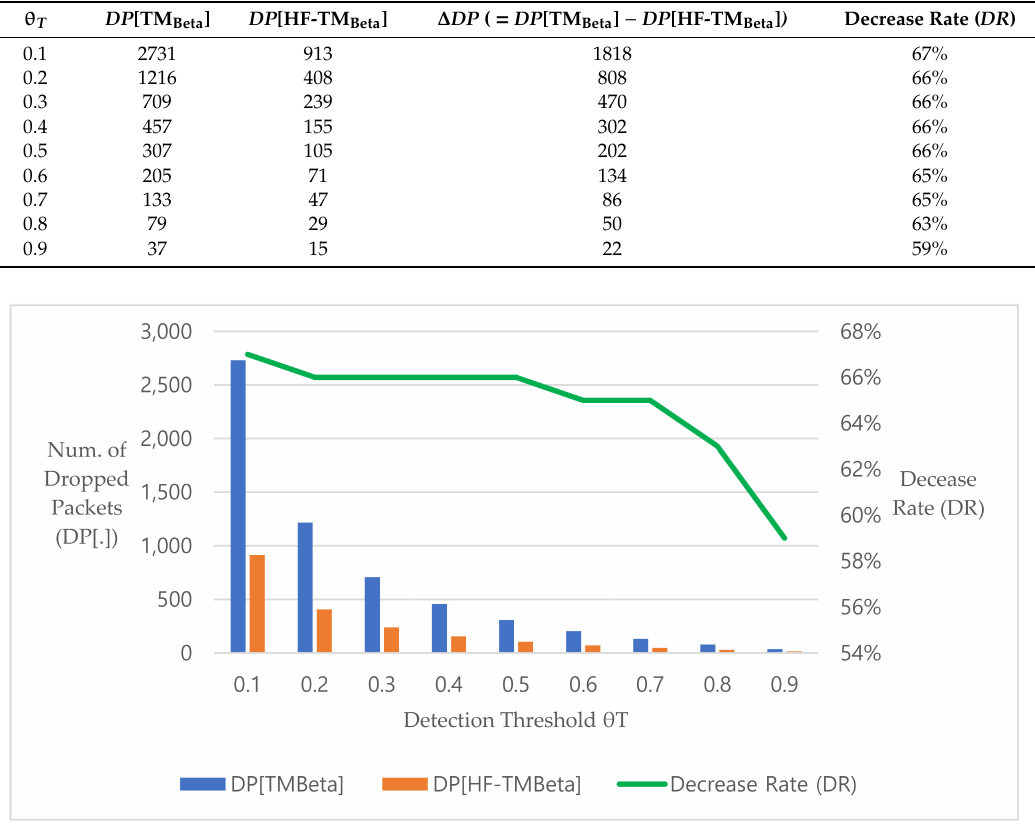
Figure 13. Experimental